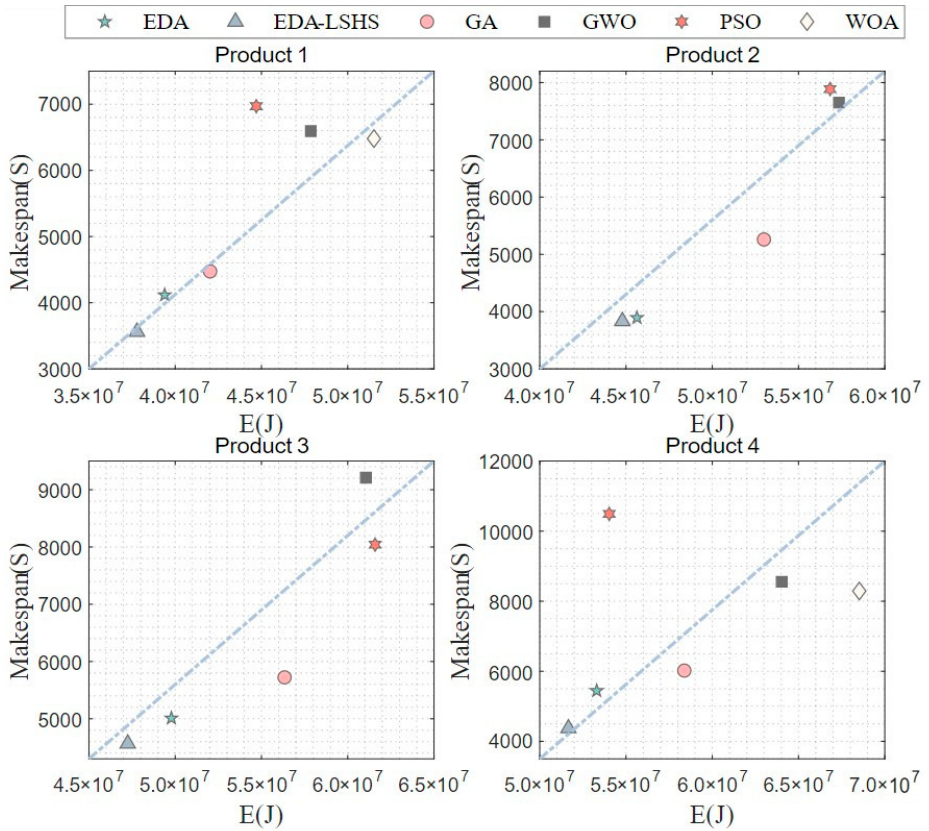
Figure 10. The comprehensive optimization effects of different algorithms for all four